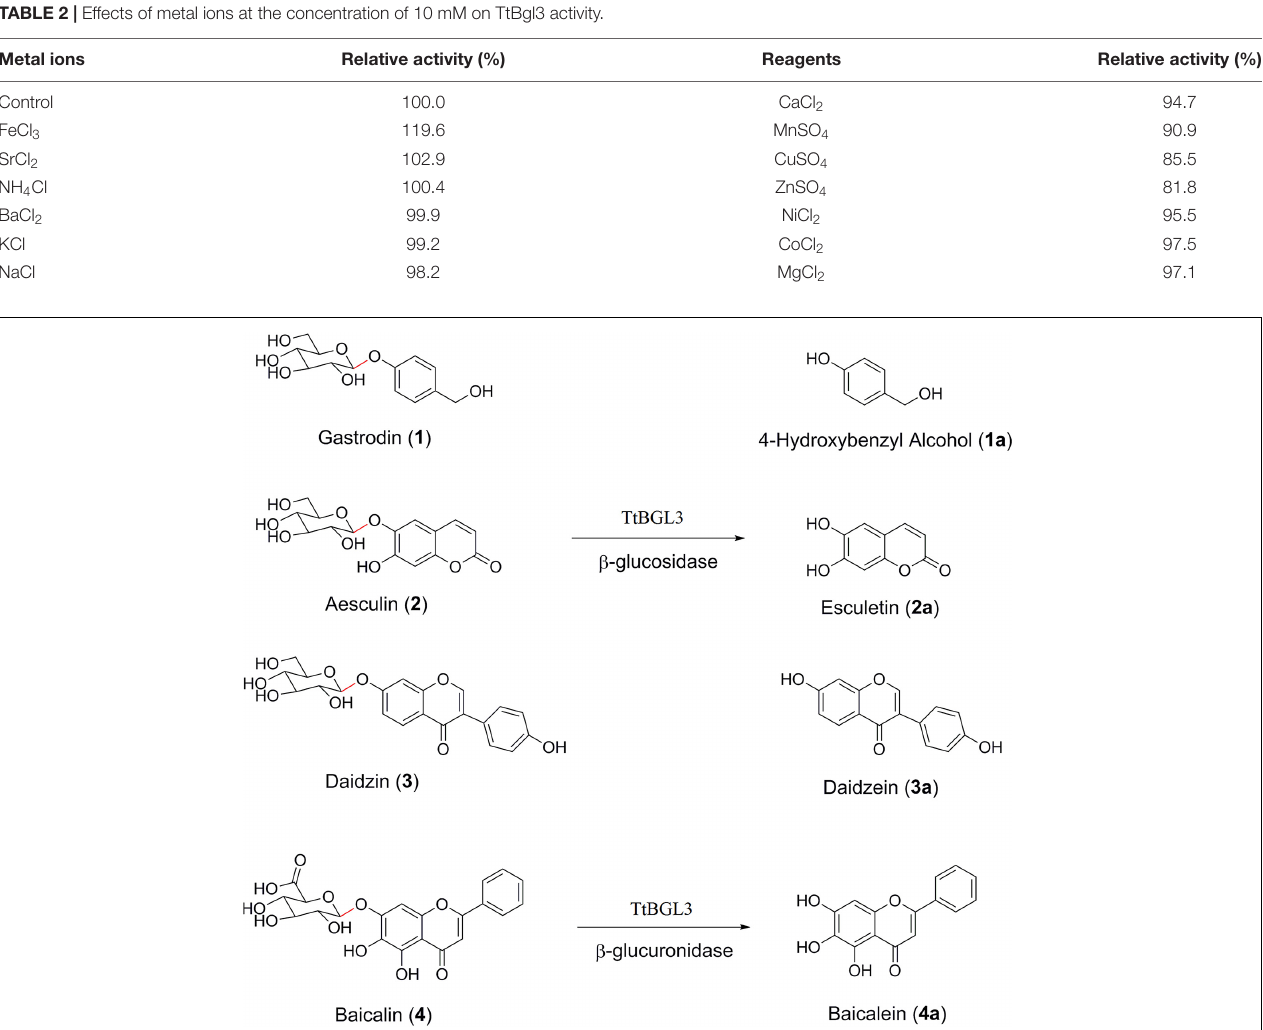
FIGURE 4 | Chemical structures of phenolic glycosides. Gastrodin (1); 4-hydroxybenzyl alcohol (1a); esculin (2); esculetin (2a); daidzin (3); daidzein (3a); baicalin (4); baicalein